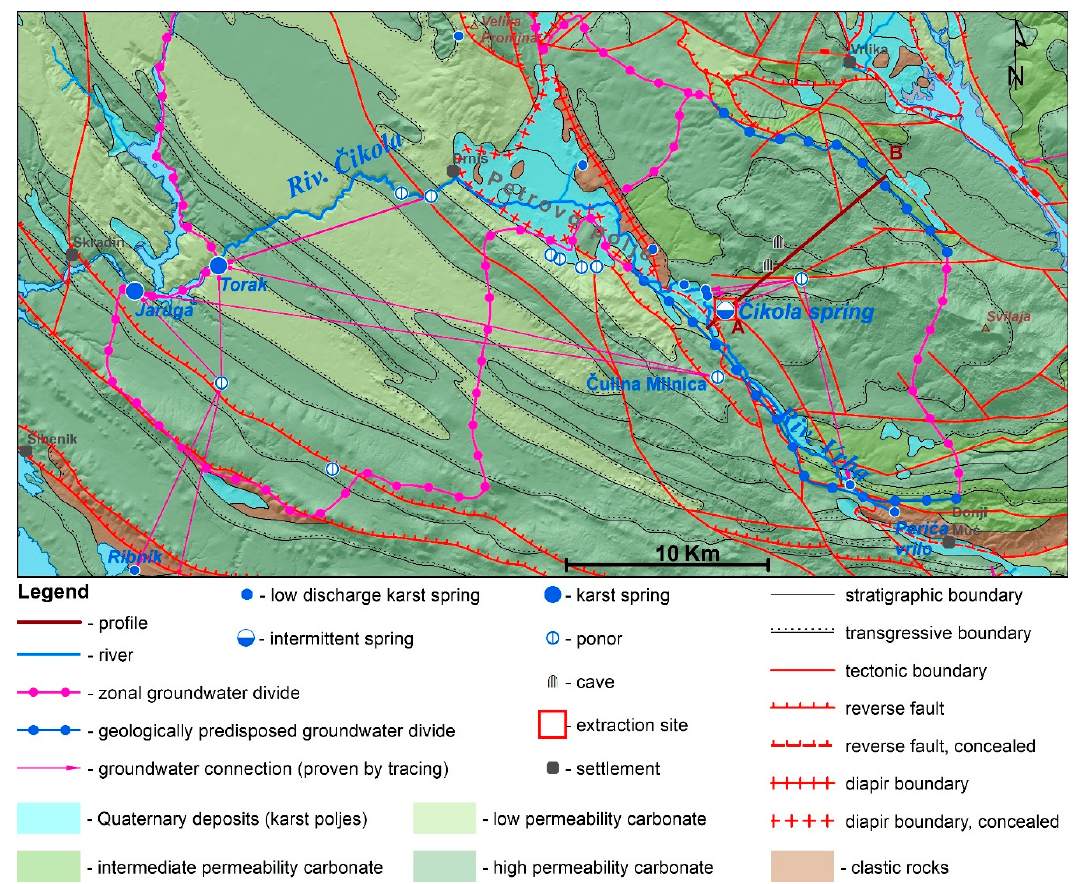
Figure 2. Hydrogeological map of the research area.